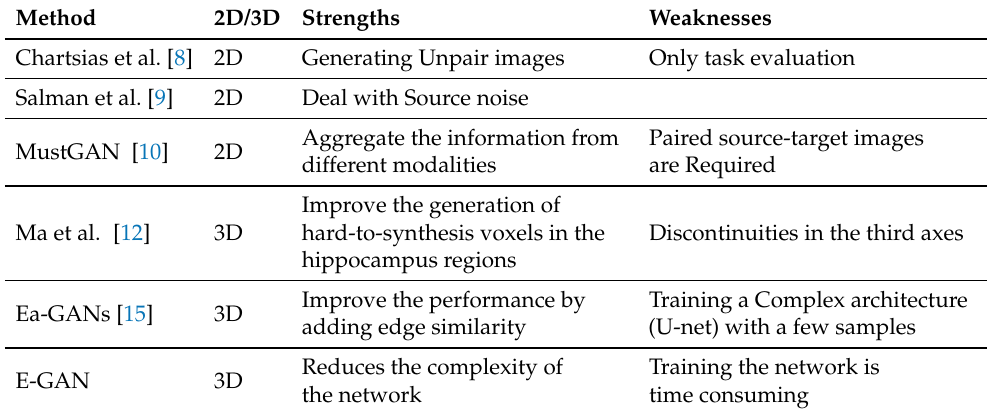
Table 1. Strengths and weaknesses of the state of the art methods and the proposed